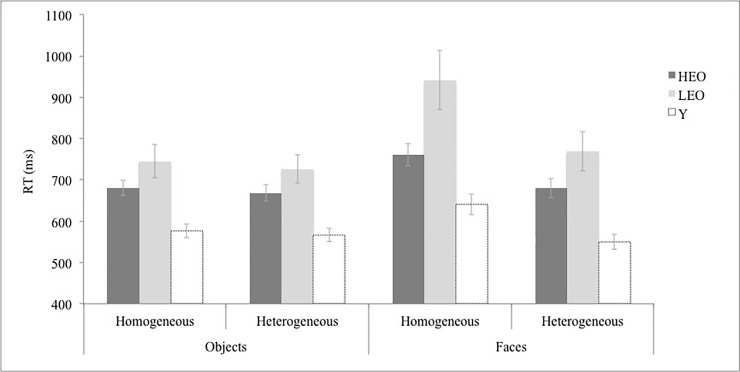
Mean naming latencies (in milliseconds) as a function of the different experimental conditions: Group (LEO; HEO; Y), stimulus type (objects vs. faces) and context (homogeneous vs. heterogeneous).